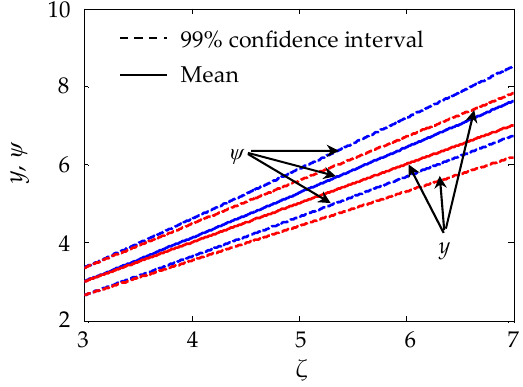
Figure 7. Confidence intervals and means of y and Ψ .